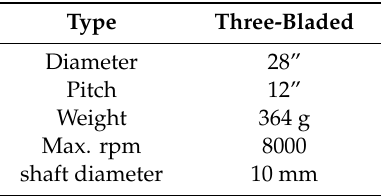
Table 8. ALO propeller main characteristics.